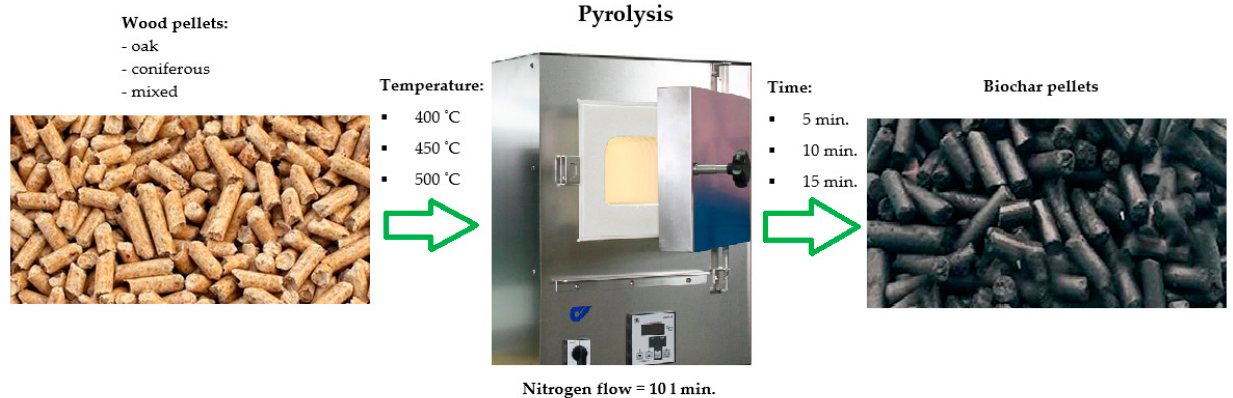
Figure 2. Diagram of the process used.